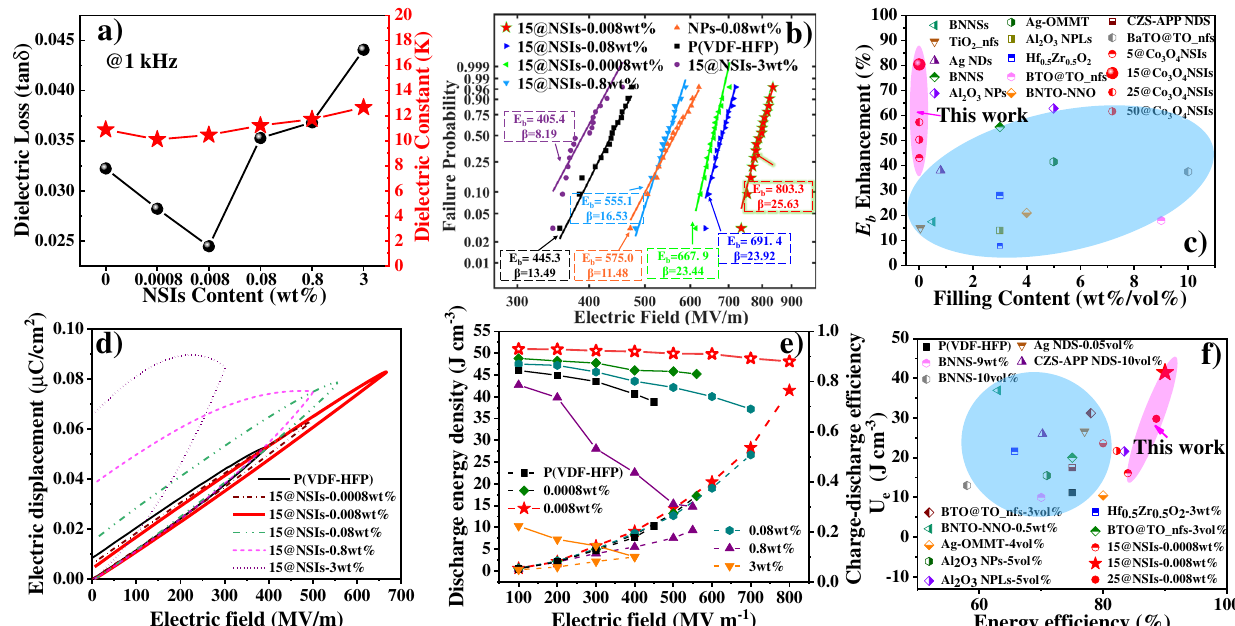
Fig. 2 | Dielectric properties and energy storage capability. a Relative permit- tivityanddispassionfactorofP(VDF-HFP)andCo 3 O 4 NSIs-based fi lmsasafunction of NSIs content. b Two-parameter Weibull distribution of the breakdown strength of the P(VDF-HFP) and 15@NSIs/P(VDF-HFP) with different fi ller contents; the characteristicbreakdownstrengthE b andshapeparameter β arederivedfromeach composition. c Comparison of breakdown strength enhancement ratio as a